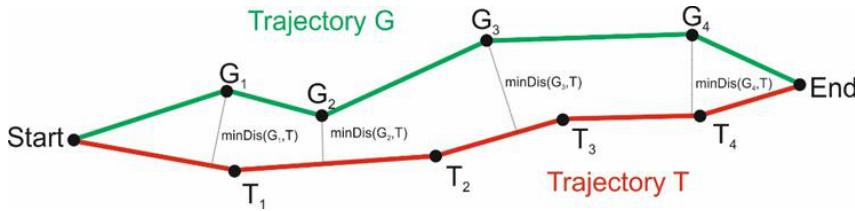
Figure 6. Calculation of Segment-Path distance for points of trajectory 𝐺 to segments of trajectory 𝑇 . 𝑚𝑖𝑛𝐷𝑖𝑠(𝐺 𝑖 ,𝑇) denotes the minimal distance of point 𝐺 𝑖 to trajectory 𝑇 .